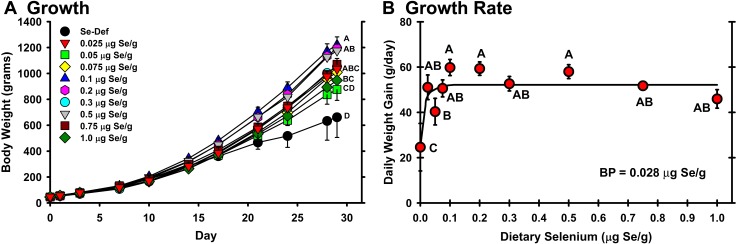
Effect of dietary Se on growth and growth rate in chicks.A. Body weights of day-old male chicks supplemented with graded levels of dietary Se at the indicated levels for 29 d (n = 5/treatment) and weighed biweekly. Values are the mean weight±SEM. Means at day 29 without a common letter are significantly different (P<0.05). B. Daily weight gain of chicks over days 14–29, calculated as g/day. Hyperbolic line is the resulting Se response curve with a breakpoint (BP) of 0.028 μg Se/g diet, calculated as described in the text. Means without a common letter are significantly different (P<0.05).